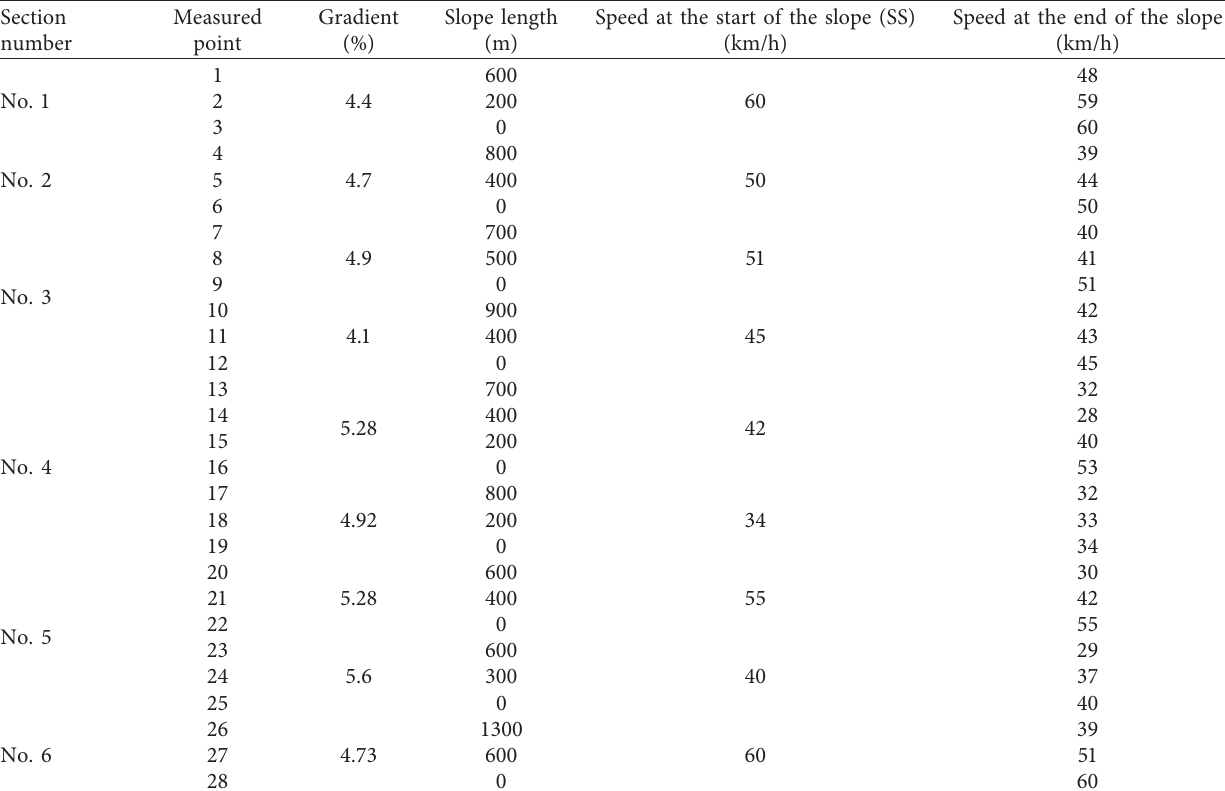
Table 2: The average truck speed under different gradients and slope lengths.